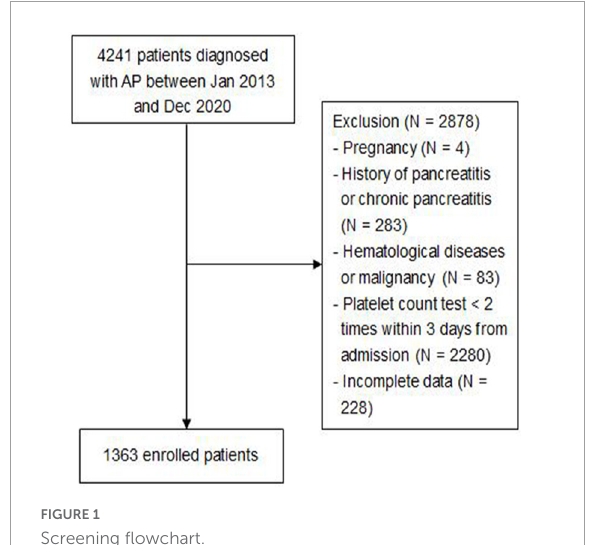
FIGURE1 Screening